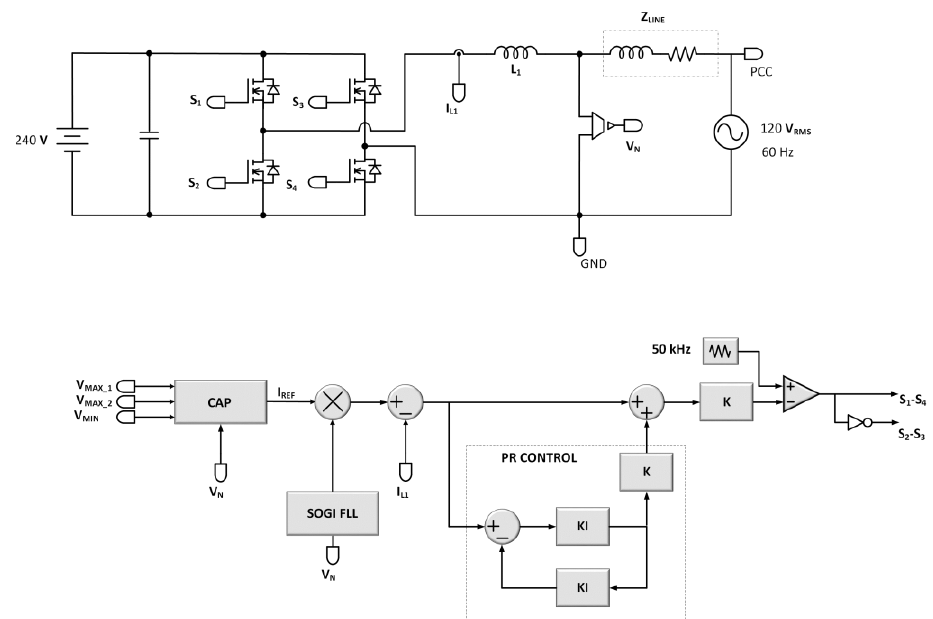
Figure 7. Proposed